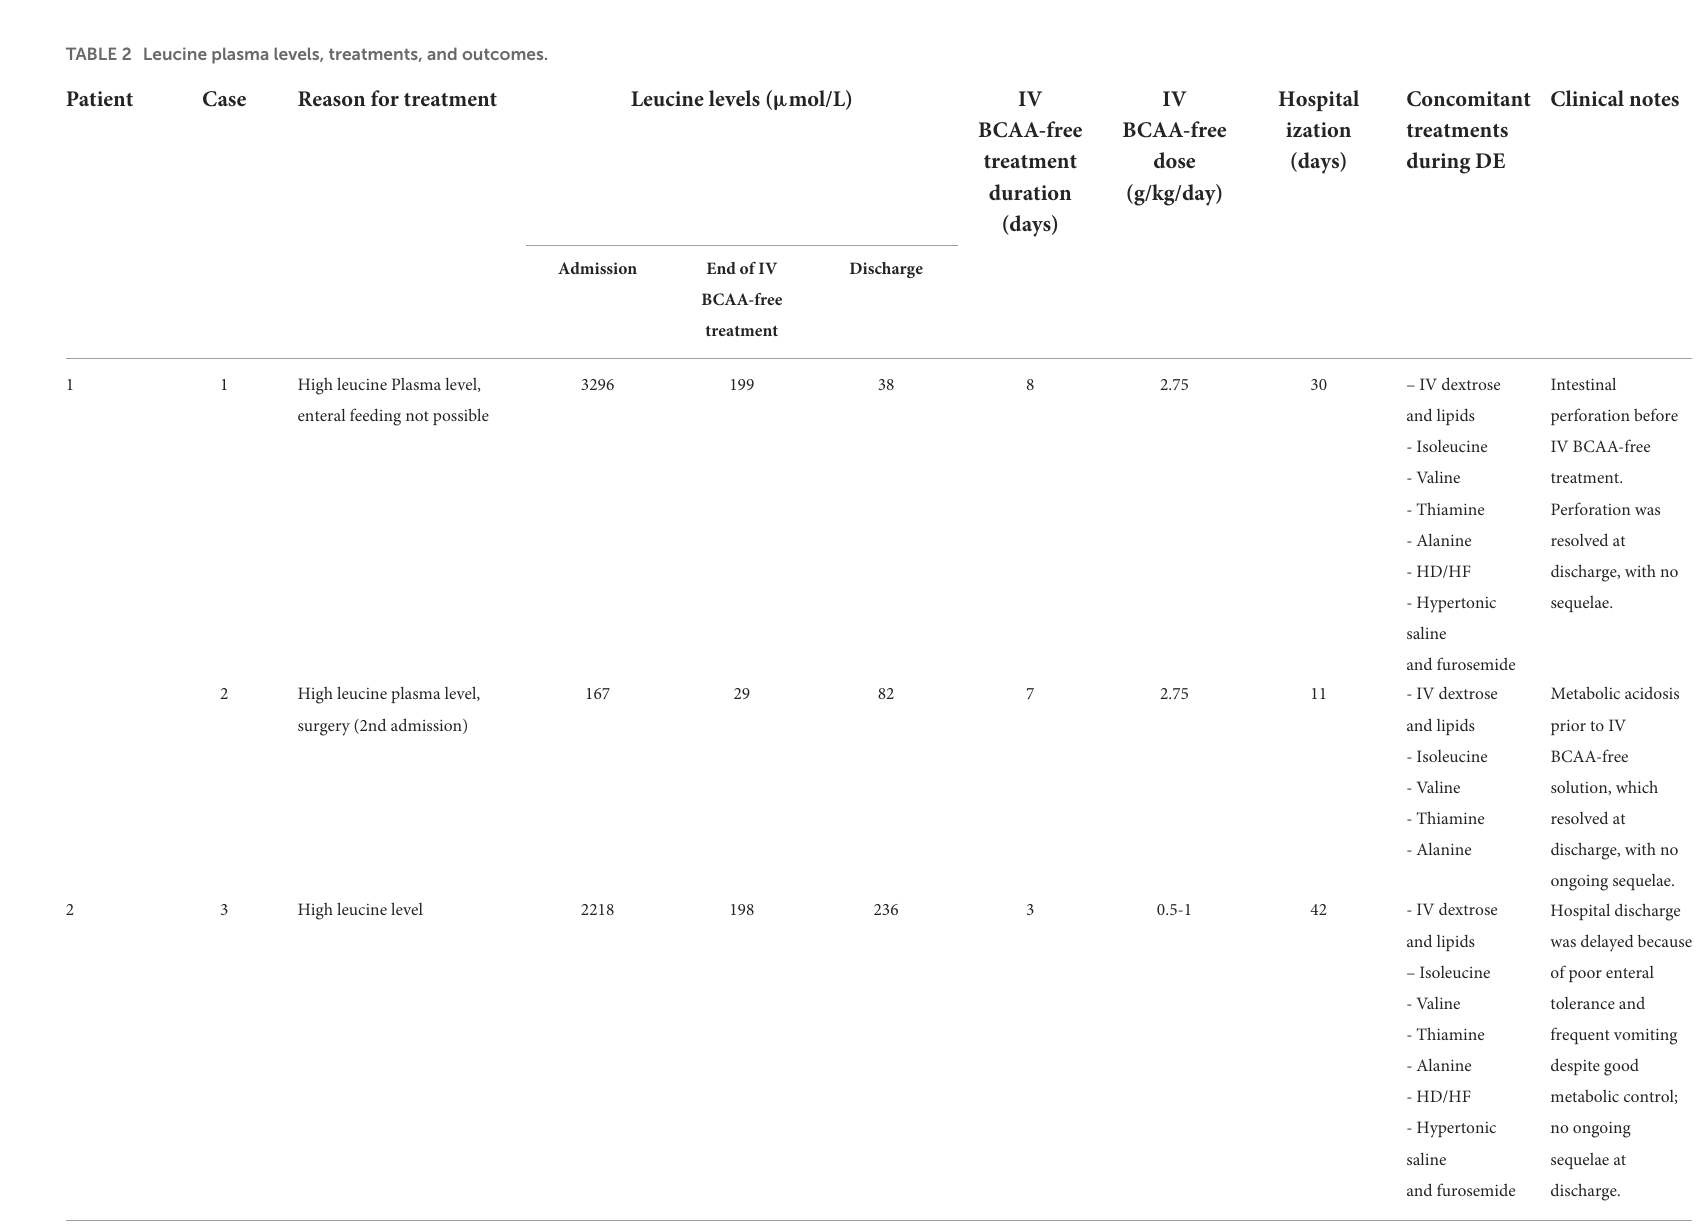
TABLE 2 Leucine plasma levels, treatments, and